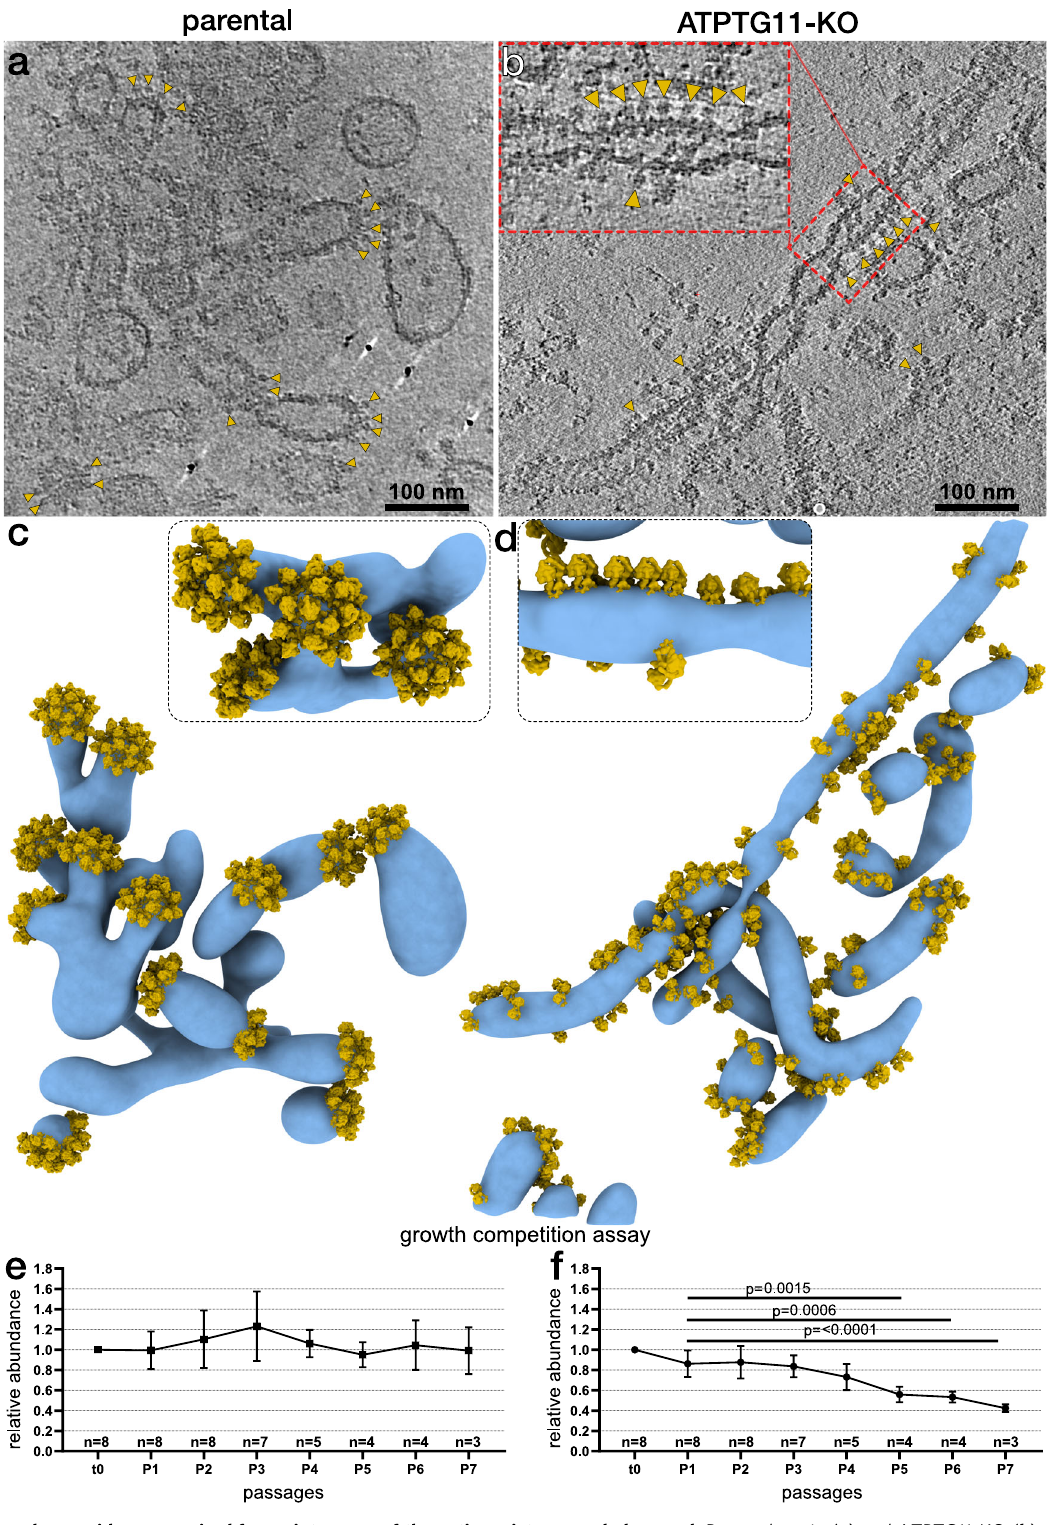
Fig. 7 Pentagonal pyramids are required for maintenance of the native cristae morphology. a , b Parental strain ( a ) and ATPTG11-KO ( b ) cross sections of tomograms of mitochondrial membranes decorated with ATP synthase (yellow arrows). c , d Segmentation of mitochondrial membranes (blue) with repositioned subtomogram averages of the dimers (yellow). Whereas the parental strain forms pentagonal pyramids that cap the bulbous membrane protrusions, hexamer and pyramid formation is disrupted in ATPTG11-KO, and ATP synthase dimers arrange in row-like or disordered arrays along elongated or tubular membranes. Close-up views show the pentagonal pyramid in the parental strain and row-like arrangements in the mutant strain. e , f Relative abundances of parental ( e ) and ATPTG11-KO ( f ) of the mixed-culture growth competition assay as determined by qPCR of total gDNA, normalized to t0. Each passage represents 3 – 8 biological replicates; error bars are SD; p -values were determined by one-way ANOVA followed by Dunnett ’ s multiple comparisons test comparing each passage to